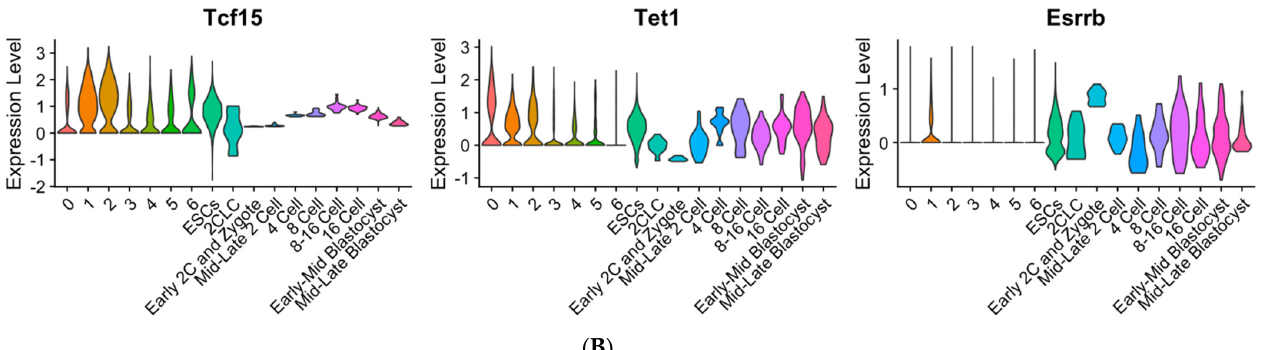
Figure 7. Totipotency gene and pluripotency gene expression of the TBLCs clusters, ESCs, early embryo cells, and 2CLCs. ( A ) Totipotent genes. ( B ) Pluripotent genes. Y -axis scale represents z-scored gene expression value.